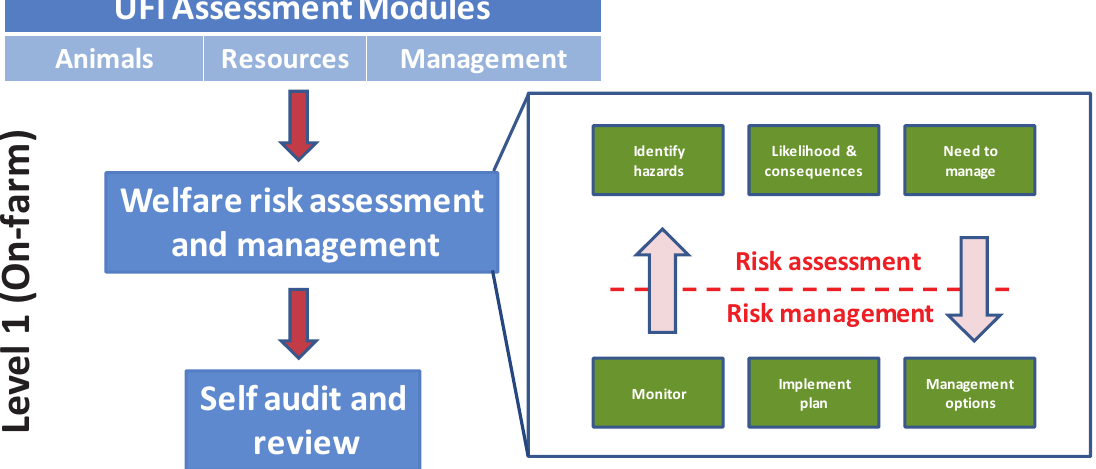
Figure 1. Level 1 (on farm) implementation of the UFI.